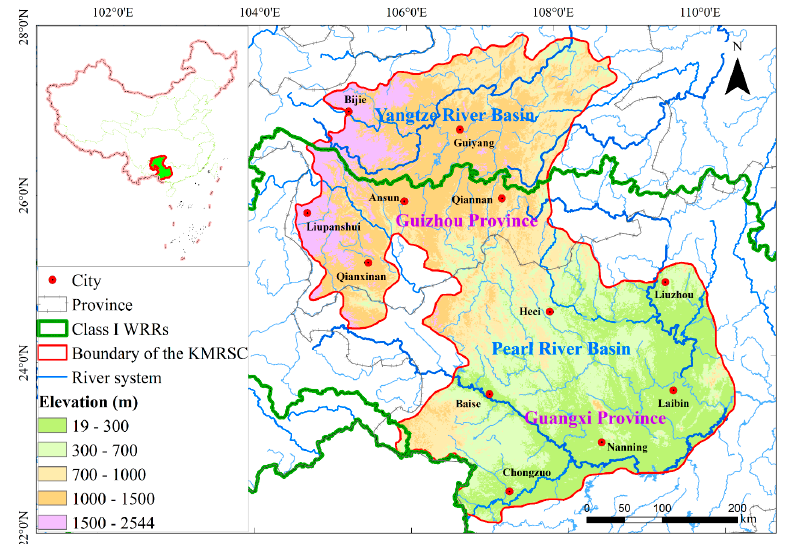
Figure 1. Geographical location of KMRSC.